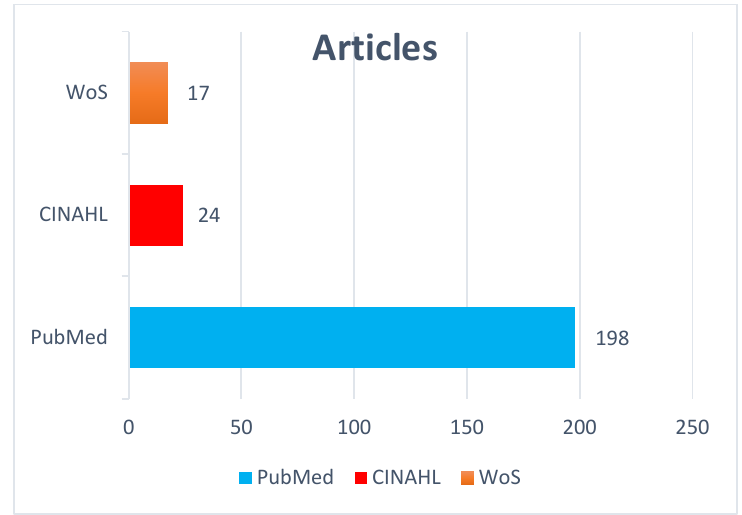
Figure 1. The number of papers identified is based on individual library sources.